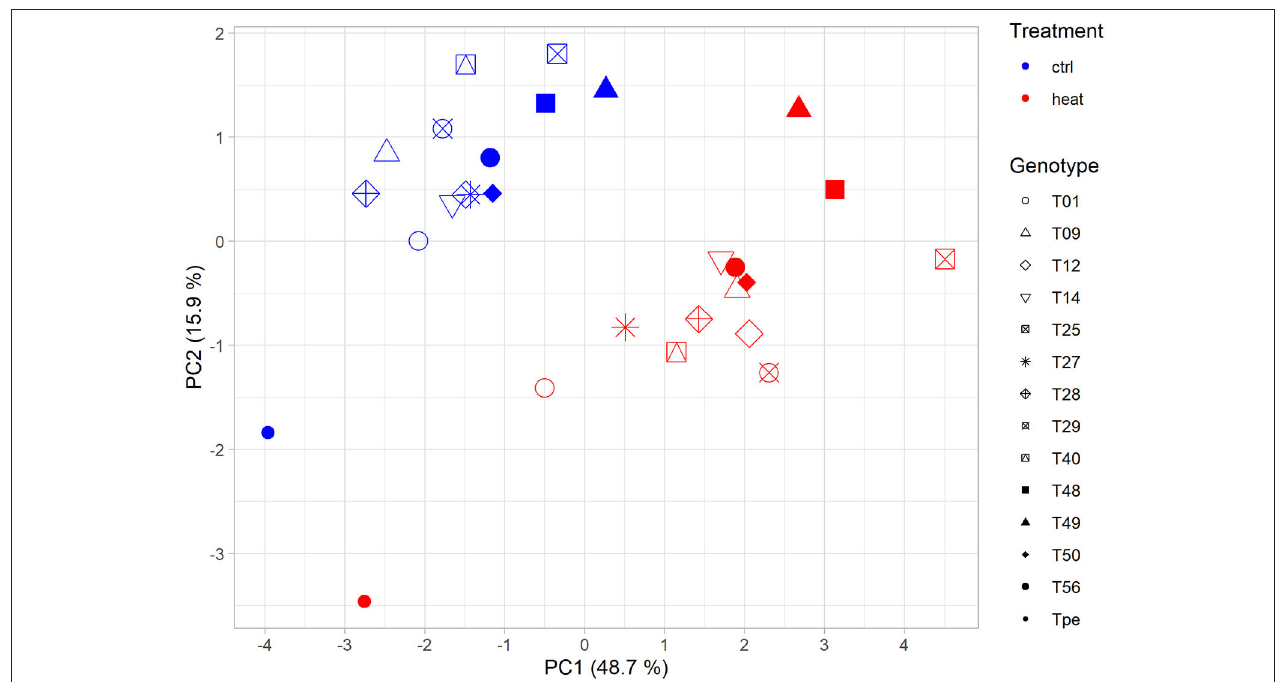
FIGURE 4 | Plotted genotypes form treatment dependent clusters. Group centroids of the genotypes and their respective treatment were used for plotting. Group centroids were calculated from the individual coordinates of each sample within PC1-3 ( Supplementary Table S3 ). Treatment (color) and genotype (shape) were used to visually examine the